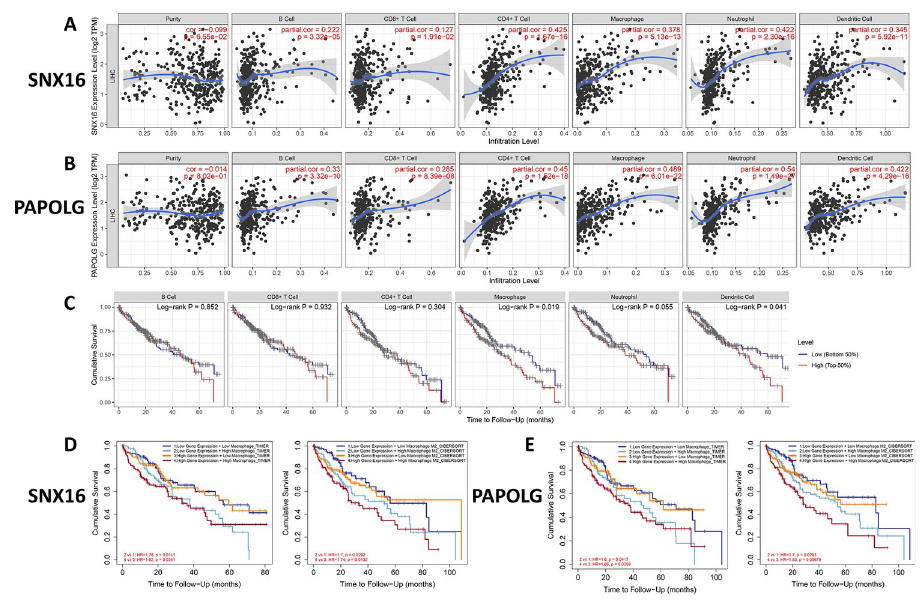
Fig 11. Correlation analysis of SNX16 and PAPOLG expression with immune infiltration. Correlation of SNX16 (A) and PAPOLG (B) expression with the level of immune cell infiltration. (C) Survival curves to analyze the relationship between six types of immune cell infiltration and overall survival of patients with HCC. Kaplan-Meier survival curves to analyze the effect of SNX16 (D) and PAPOLG (E) expression with macrophages and M2 macrophages on the overall survival of patients with